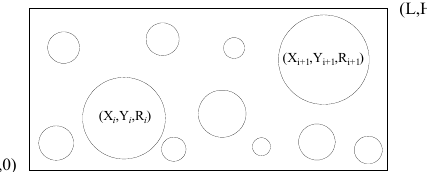
Figure 4. The generation of the aperture model.